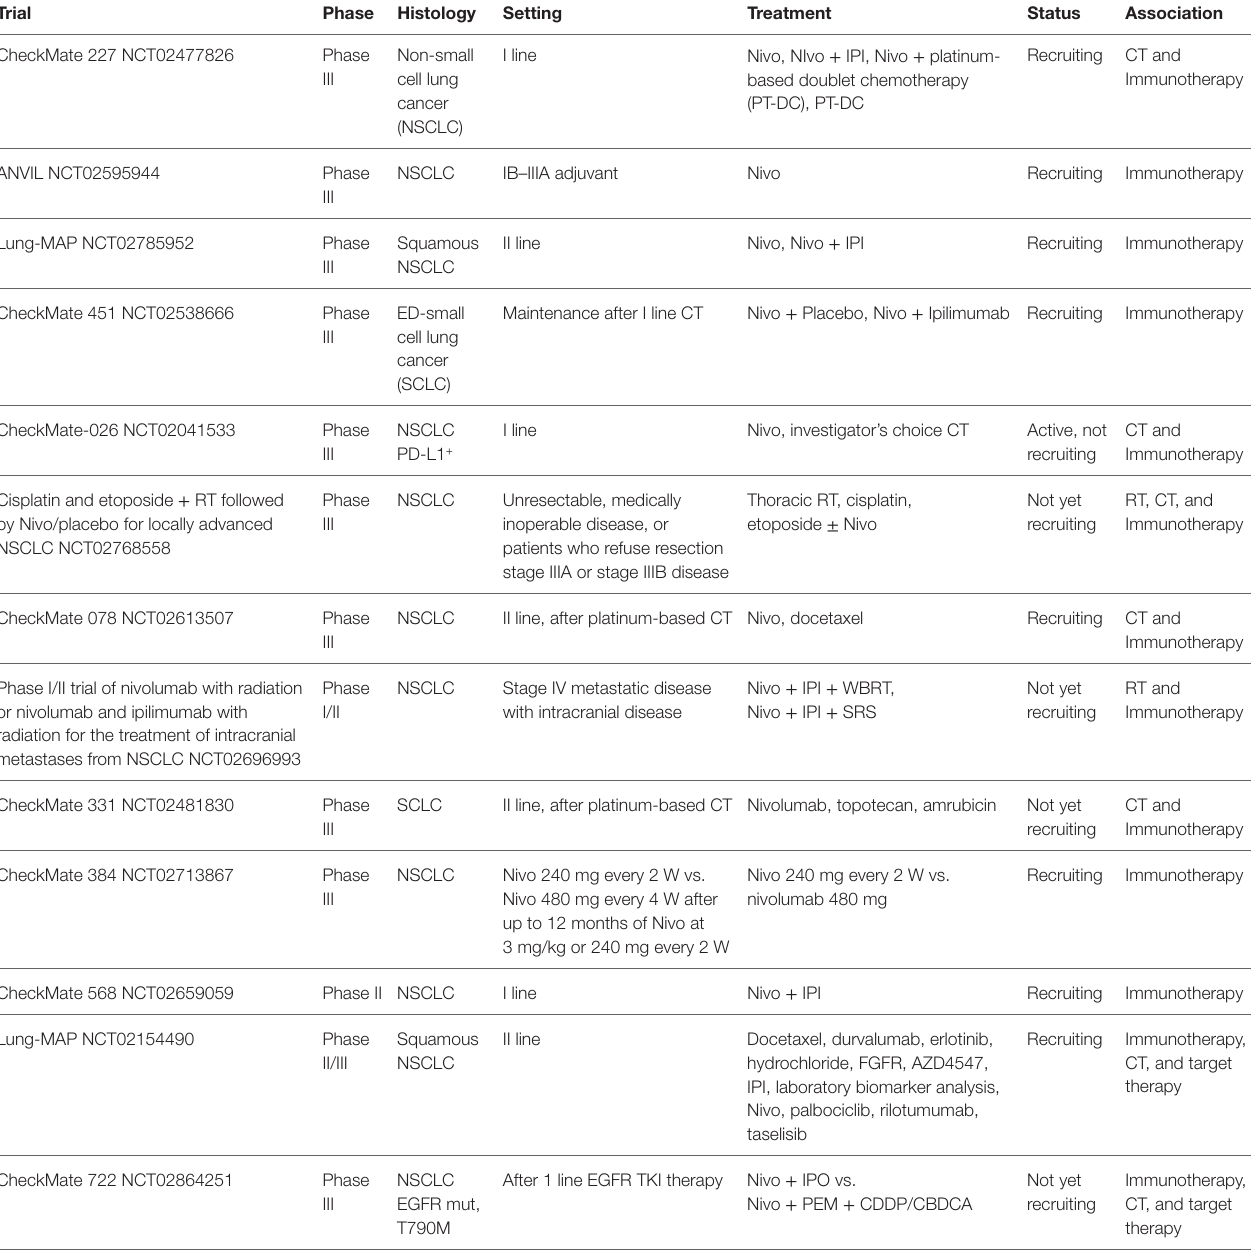
TABLe 2 | Selected future development of nivolumab in lung